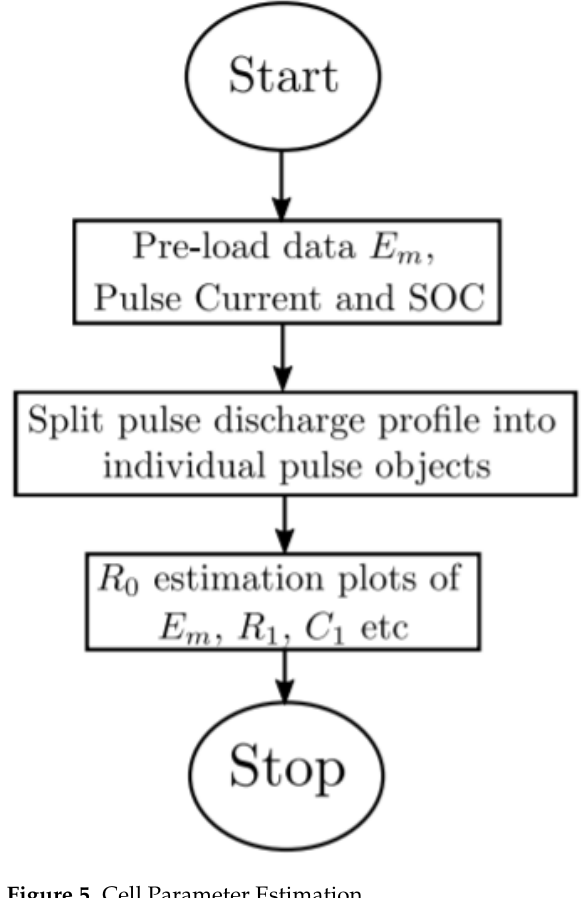
Figure 5. Cell Parameter Estimation.